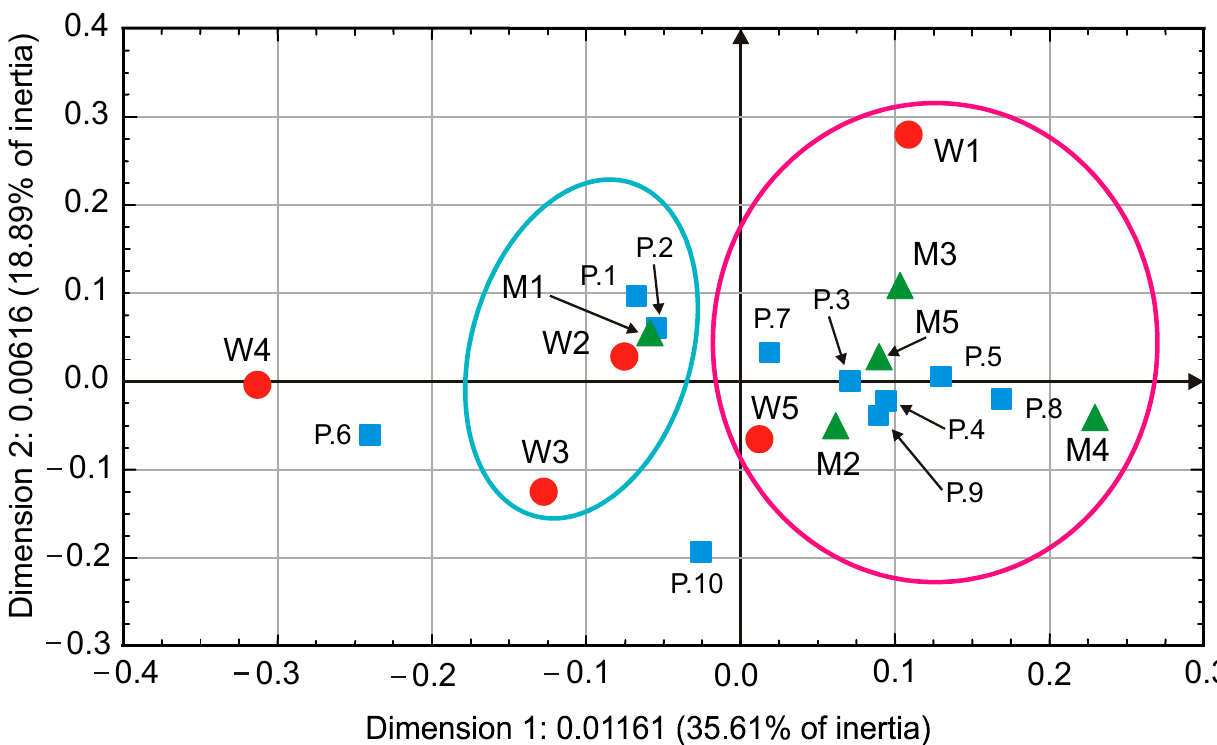
Figure 3. 3D plot of column and row coordinates: dimension 1 × 2 × 3. Input table (rows × columns): 10 × 10.